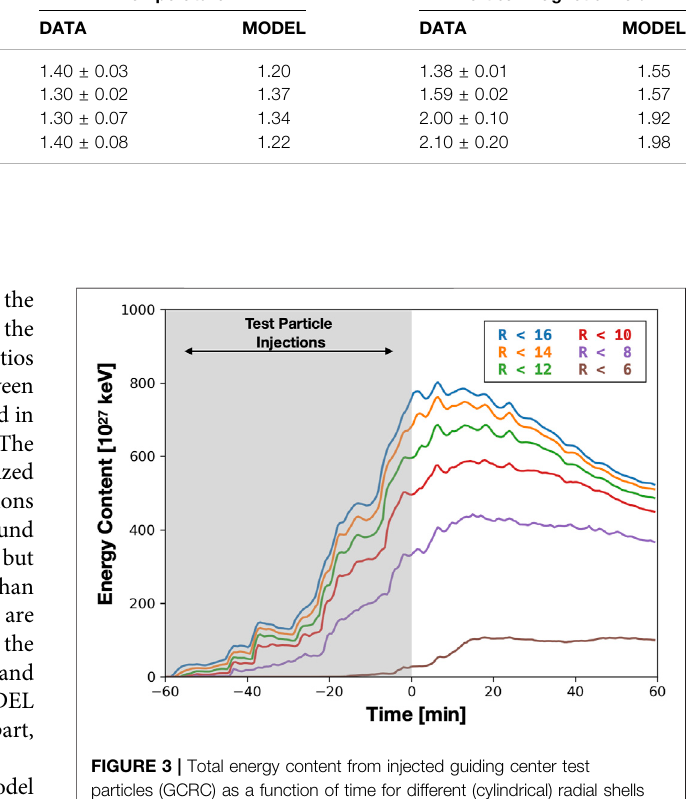
TABLE 1 | Data-model comparison of BBF statistics. Shown are the results of a statistical study (DATA; Runov et al., 2015) looking at the relative density, temperature and magnetic fi eld strength ofBBFs to the background plasma. We construct analogous, although not identical, statistics (MODEL) from our simulation to compare against. Radial Domain [R E ]